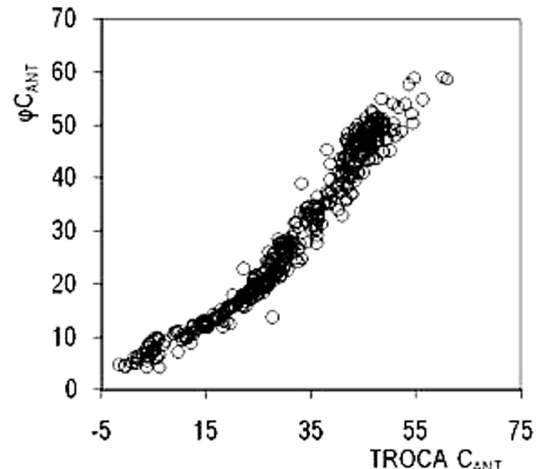
F ig. 4 . – Relationship between C calculated with the TrOCA and ANT j C T º methods (in µmol·kg -1